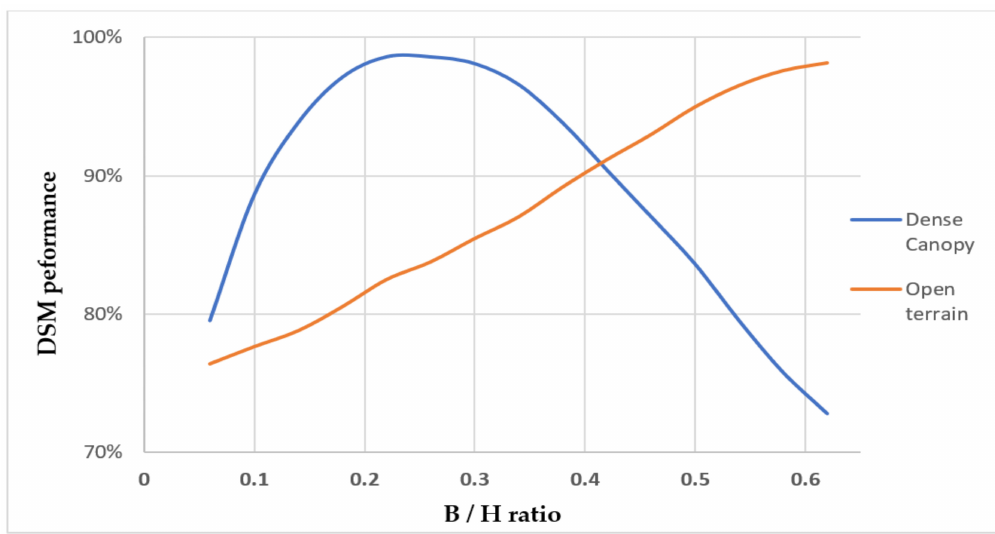
Figure 8. Relationship between the efficiency (vertical accuracy and completeness) of image-derived DSMs and base- to-height (B/H) ratio of corresponding stereo satellite and airborne imagery in hemiboreal predominantly mature, dense, closed-canopy deciduous and evergreen